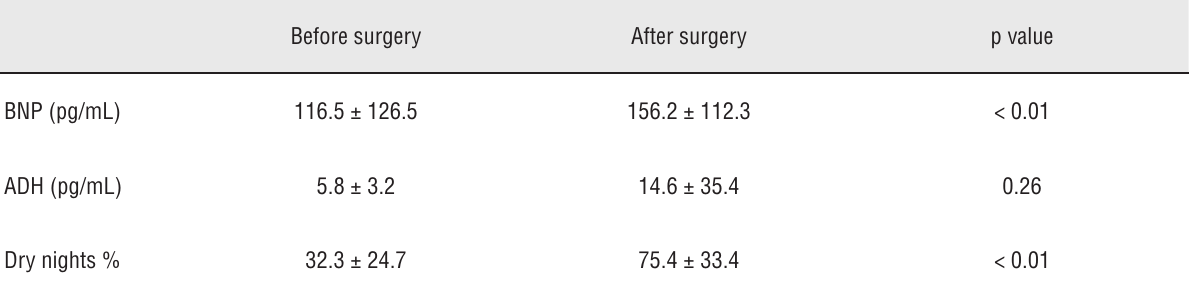
Table 1 - Mean variation from before and 90 to 120 days after airway surgery. Before surgery After